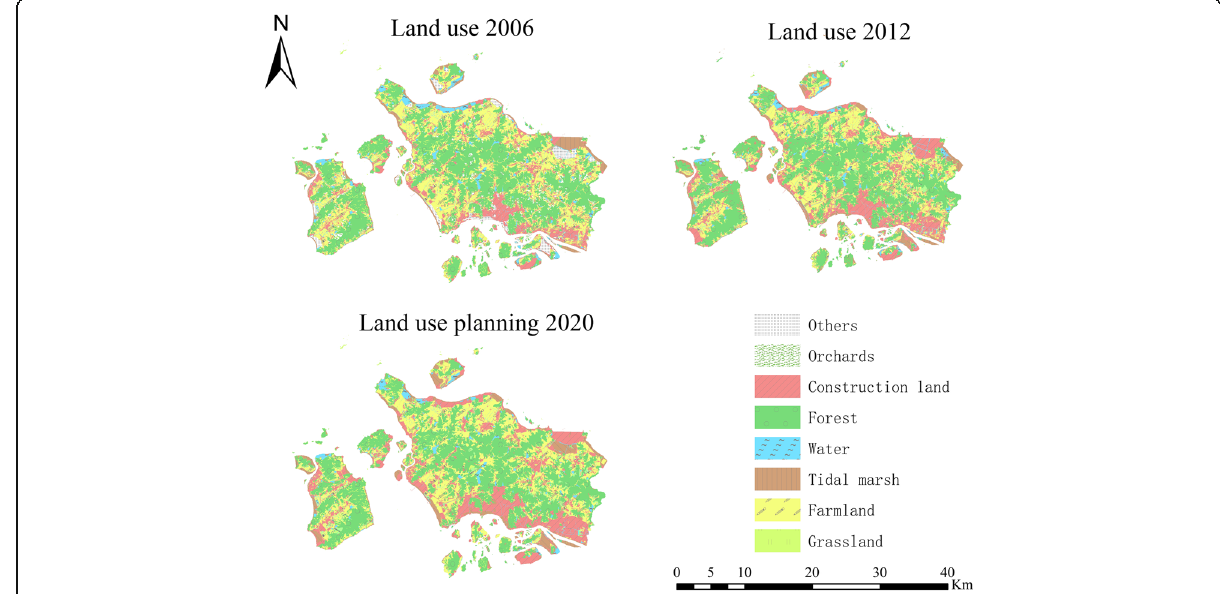
Fig. 2 Land use maps of Dinghai District in 2006, 2012, and 2020